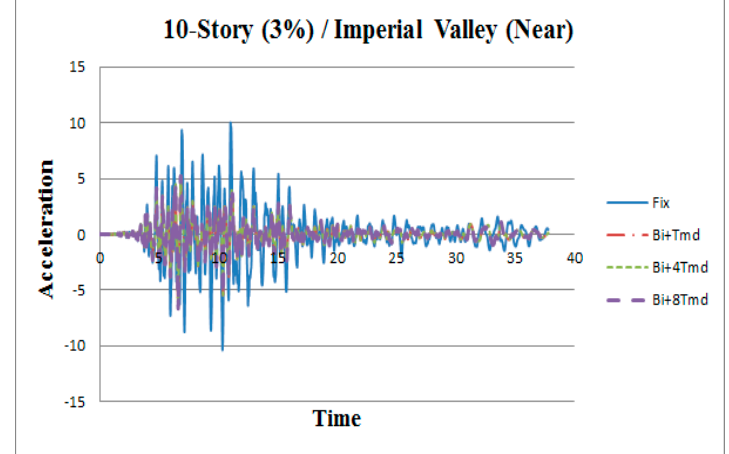
Figure 4. Acceleration time histories for top story of 10-story building under the Kern County (far-fault) earthquake.